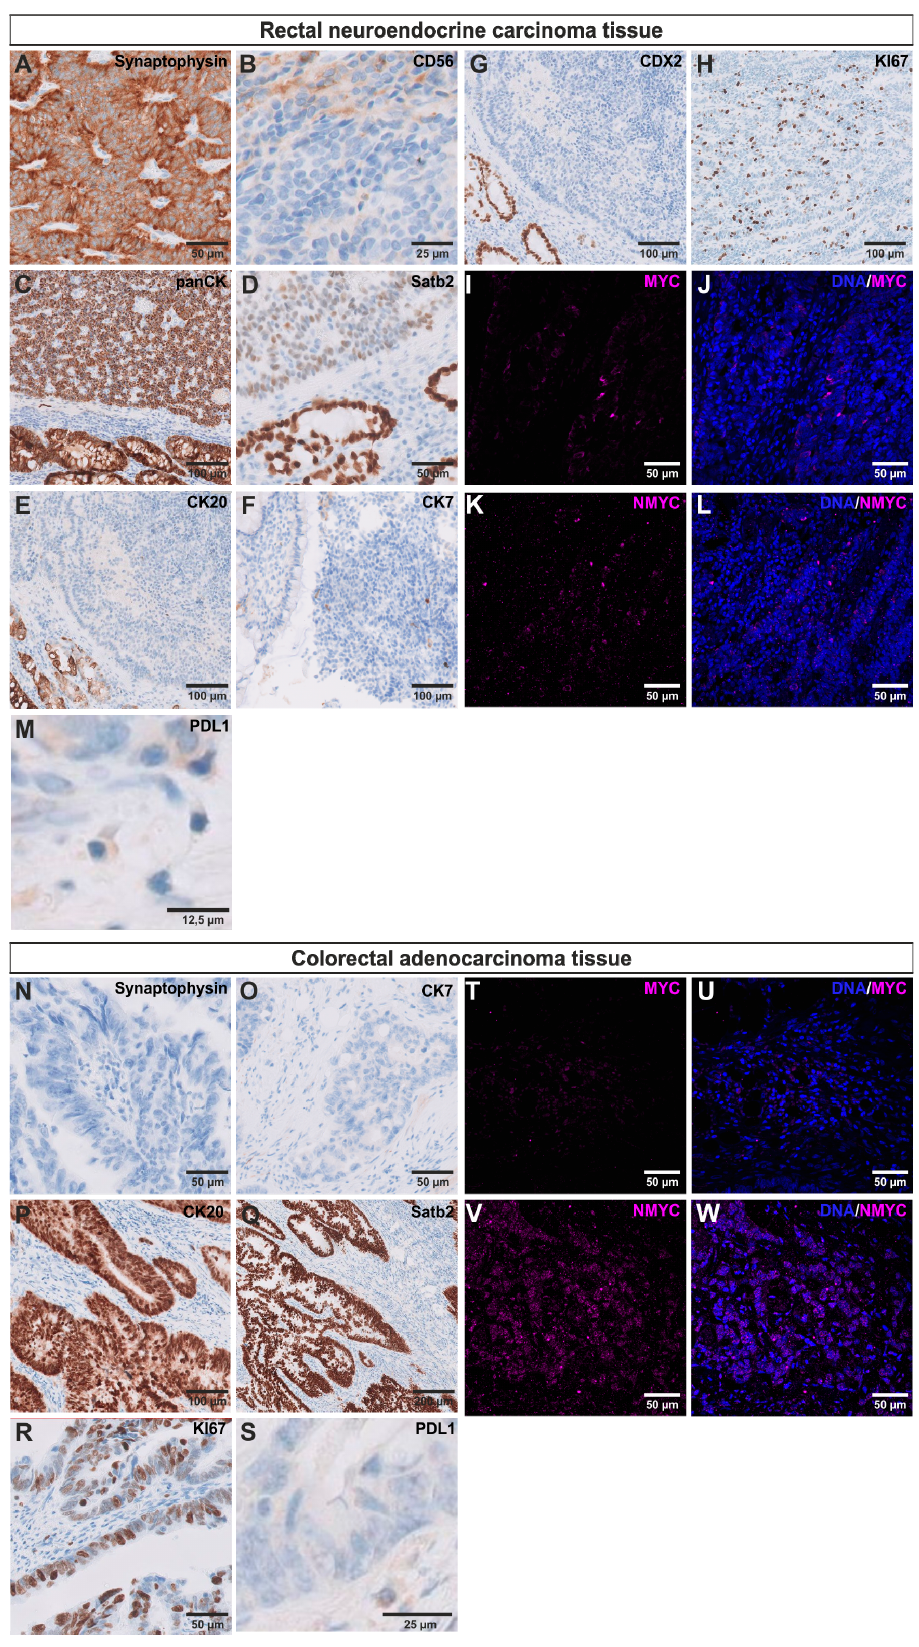
Figure2. Immunohistochemicalcharacterizationoftheprimaryrectallargecellneuroendocrinecarcinoma (NEC) and the colorectal adenocarcinoma (AC). NEC tissue was tested positive for ( A )